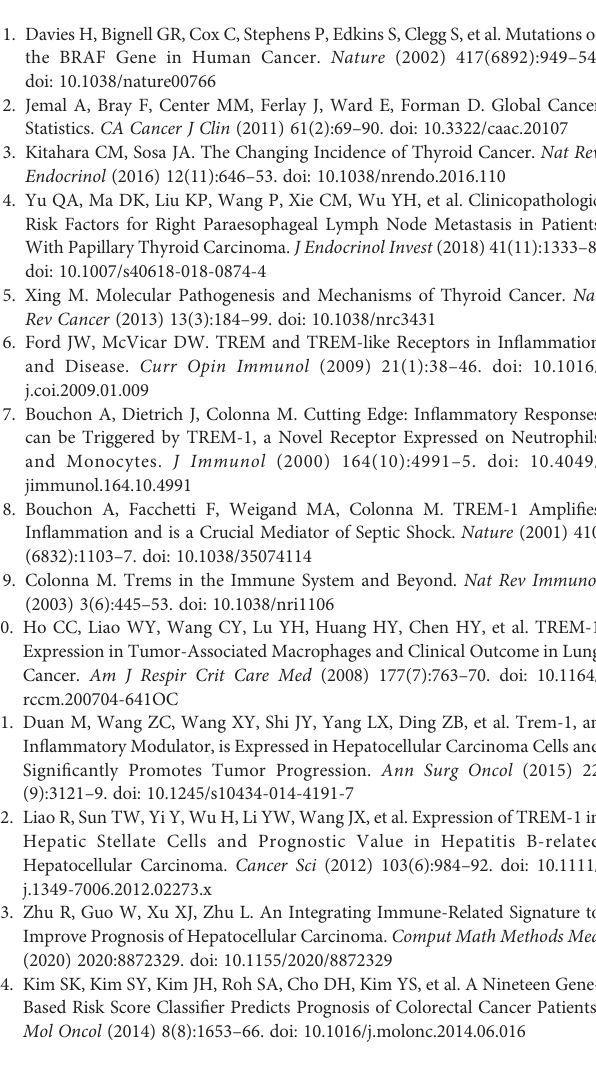
Supplementary Table 1 | Association between TREM-1 expression and immune cell proportions. Supplementary Table 2 | Association between TREM-1 expression and immune cell